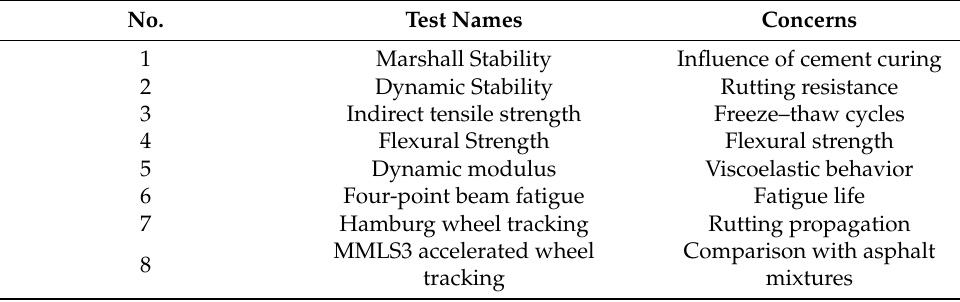
Table 1. Performance test of SFP and the major concerns.